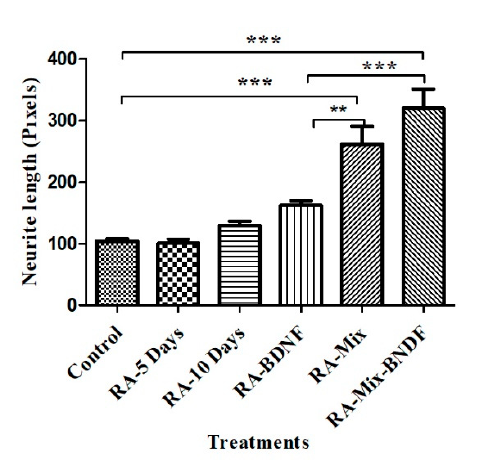
Figure 3. Neurite lengths of differentiated and undifferentiated SH-SY5Y cells. * Statistically significant changes (** p < 0.05 RA-BDNF vs RA-Mix, *** p < 0.001 control vs treated